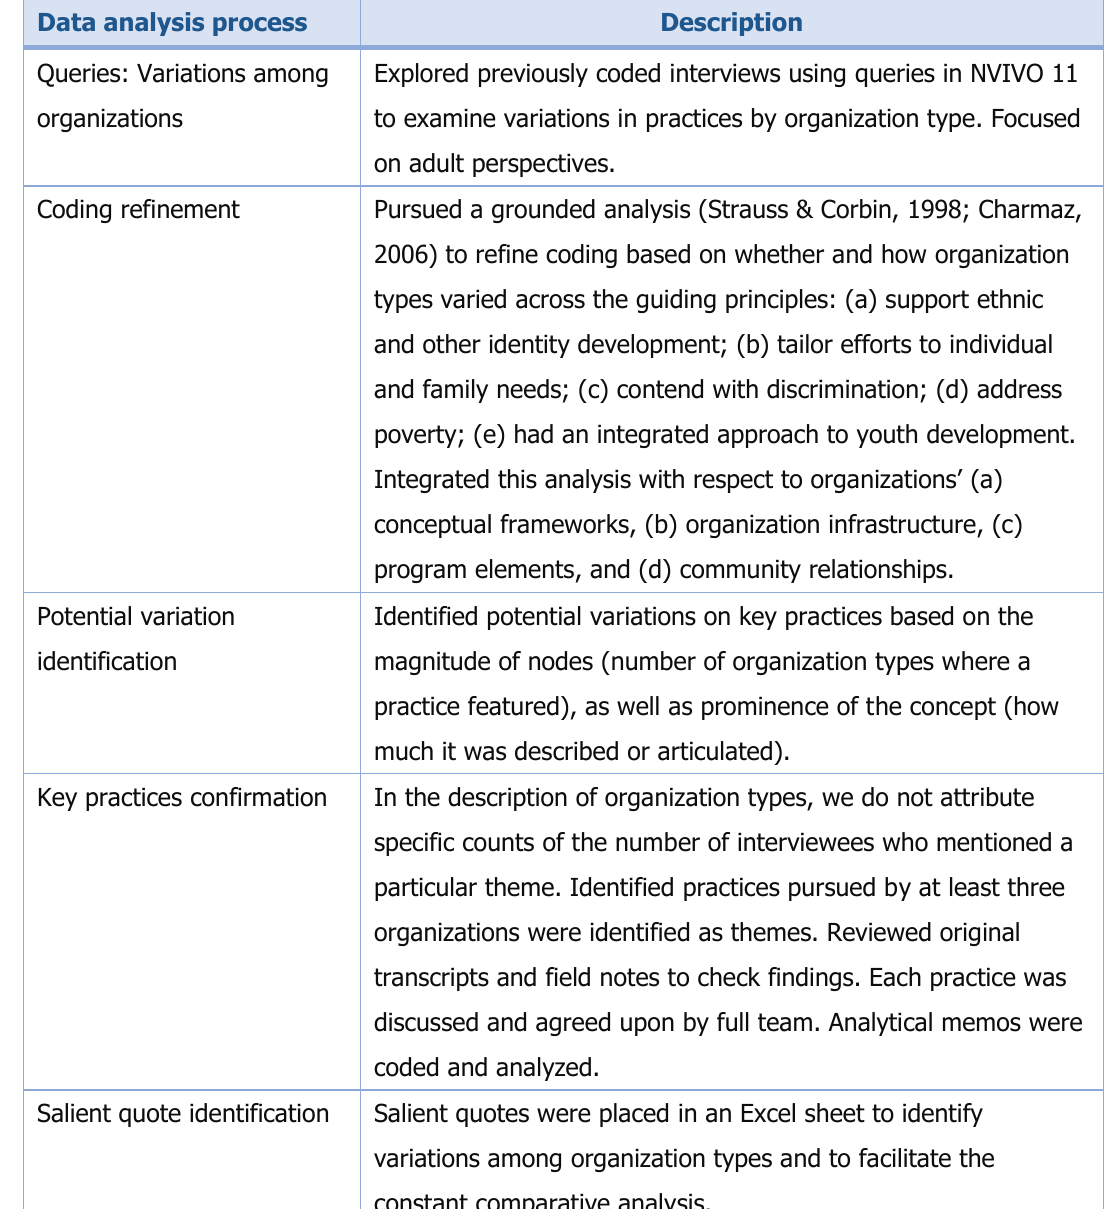
Table 3. Data Analysis Process Data analysis